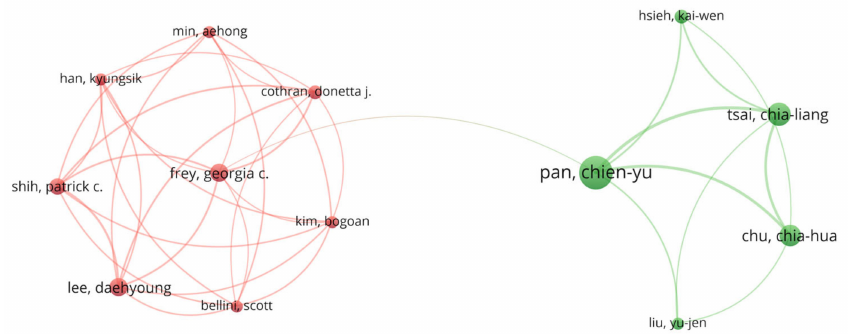
Figure 7. The author’s co-authorship network regarding PA research on ASD.